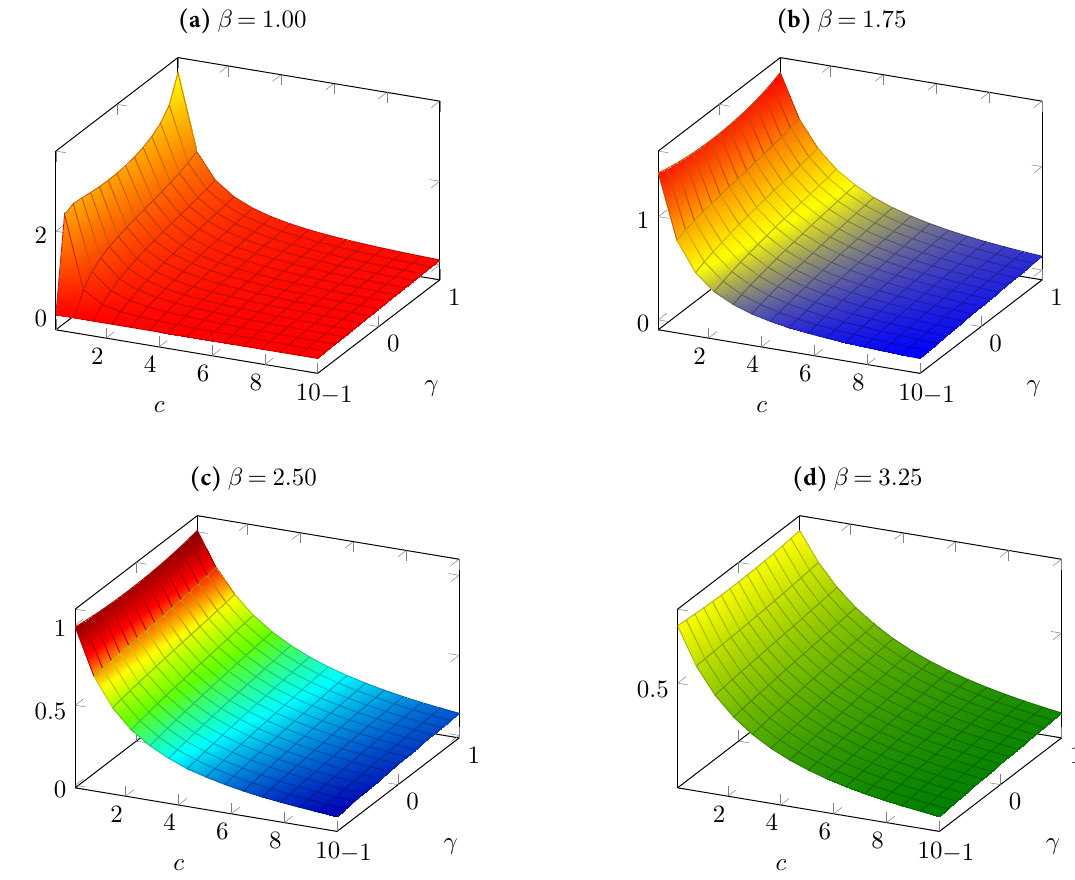
Figure 2. Plots of E [ CS SF ( α )] for various values of β , γ , and c when E [ α 2 ] = 10. 246